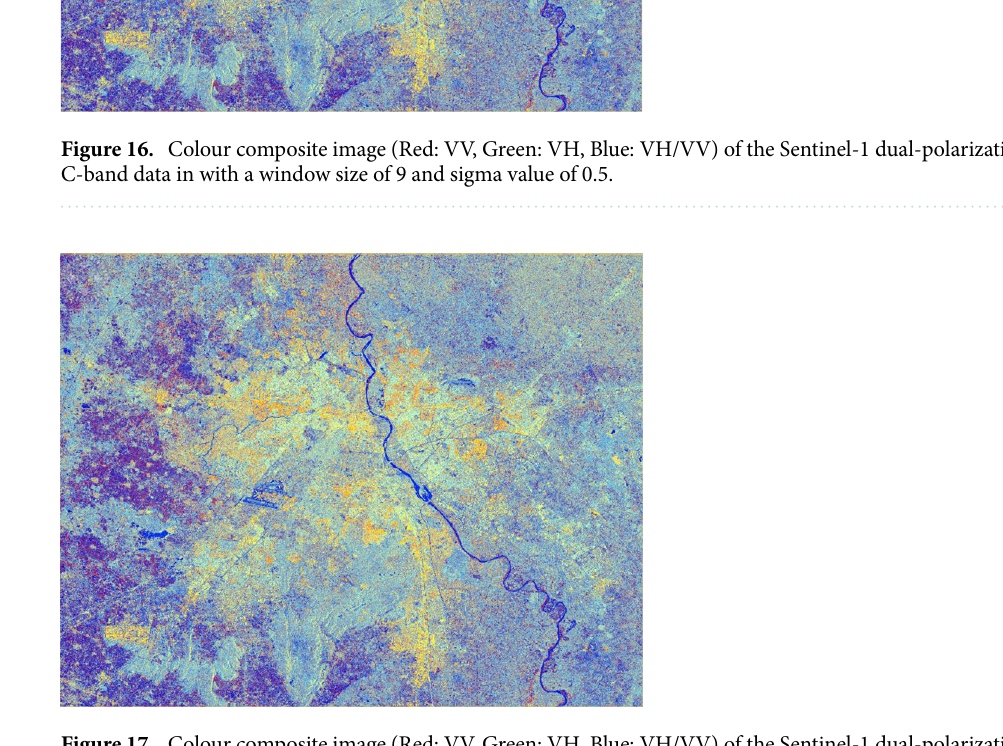
Figure 17. Colour composite image (Red: VV, Green: VH, Blue: VH/VV) of the Sentinel-1 dual-polarization C-band data in with a window size of 11 and sigma value of